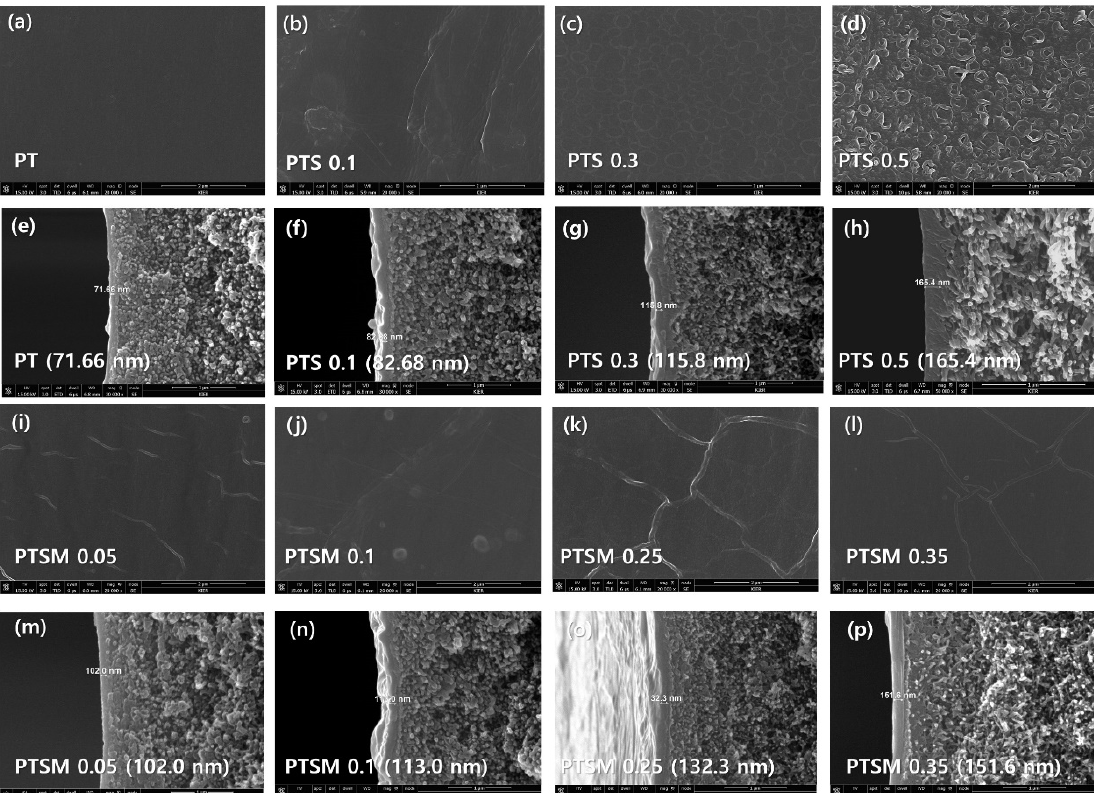
Figure 6. FE-SEM images of the thin-film composite hollow fiber membranes. Surface image (20.0 K amplification) of ( a ) PT, ( b ) PTS-0.1, ( c ) PTS-3.0, ( d ) PTS-0.5 CMMMs; cross-section image (30.0 K amplification) of ( e ) PT, ( f ) PTS-0.1, ( g ) PTS-3.0, ( h ) PTS-0.5 CMMMs; surface image (20.0 K amplification) of ( i ) PTSMP-0.05, ( j ) PTSM-0.1, ( k ) PTSM-0.25, ( l ) PTSM-0.35 CMMMs, cross-section image (30.0 K amplification) of ( m ) PTSP-0.05, ( n ) PTSM-0.1, ( o ) PTSM-0.25, and ( p ) PTSP-0.35